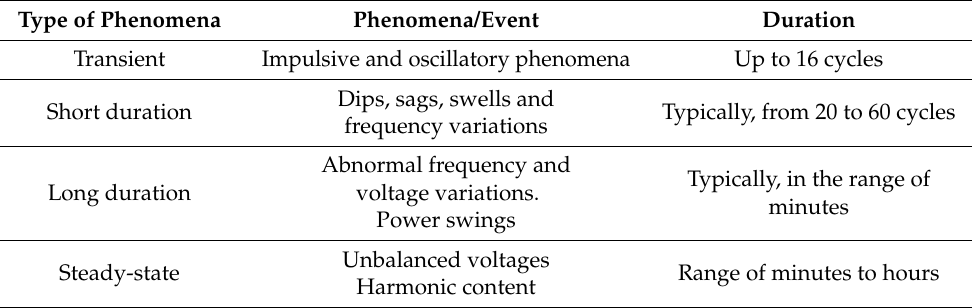
Table 5. Type and duration of events in electrical